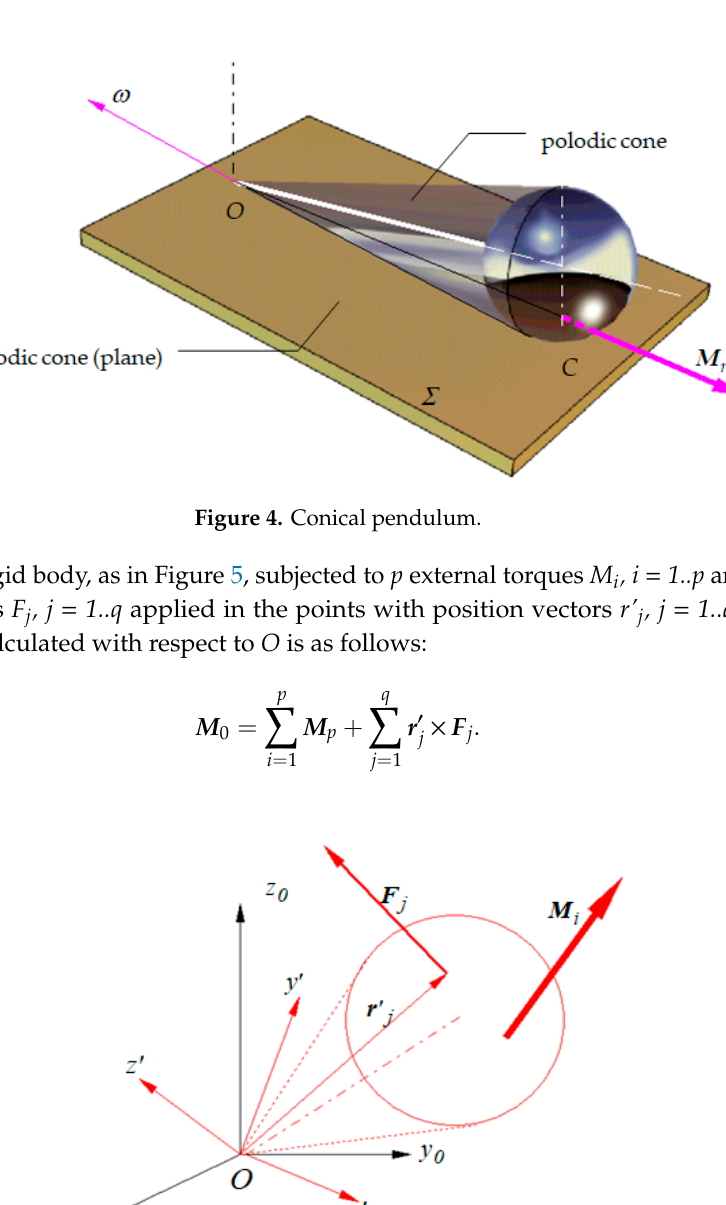
Figure 5. Rigid body subjected to generalized forces.